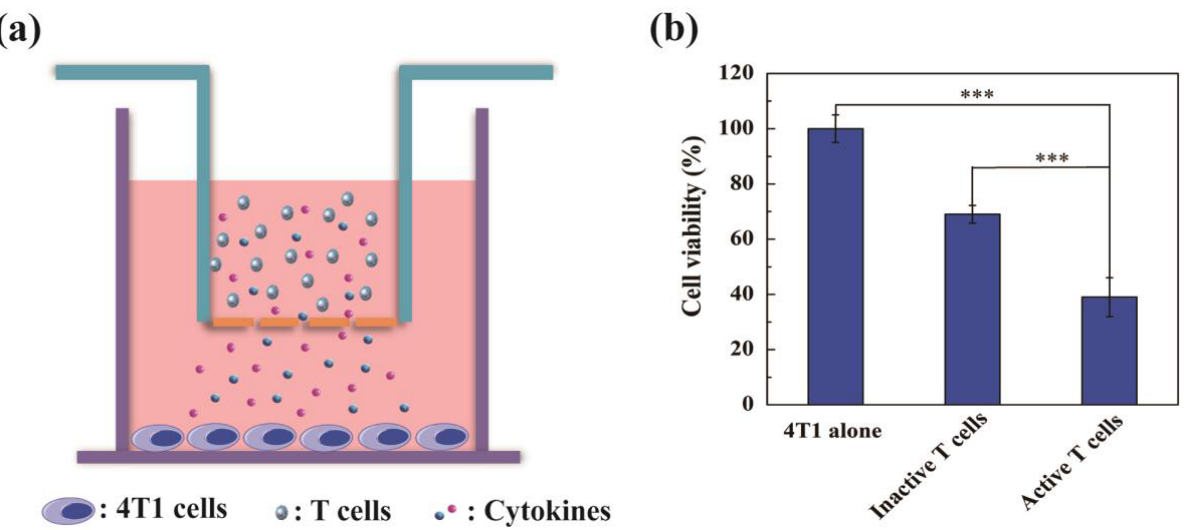
Figure 5. ( a ) Schematic illustration of T cells (upper) and tumor cell (lower) co-cultured using the transwell plates. ( b ) Cell viability of 4T1 after co-culture with different T cells. *** p < 0.001.